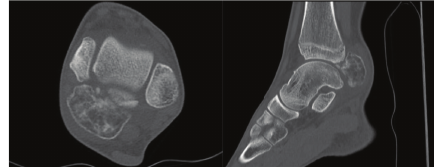
Figure 3: Preoperative CT images, axial and sagittal planes of the ankle